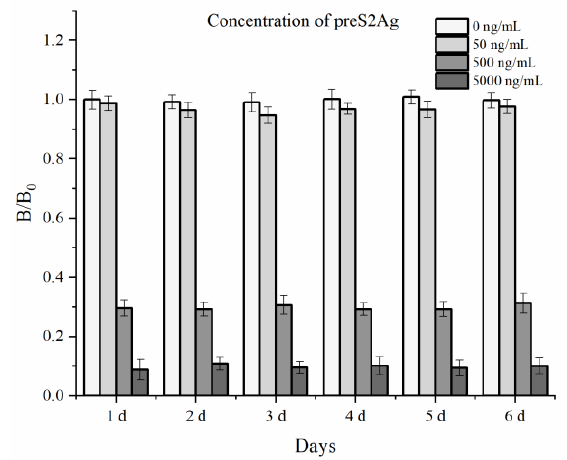
Figure 8. Stability evaluation of GAM-MNPs-ICA. The error bars represent the standard deviation of three repeats (n = 3).